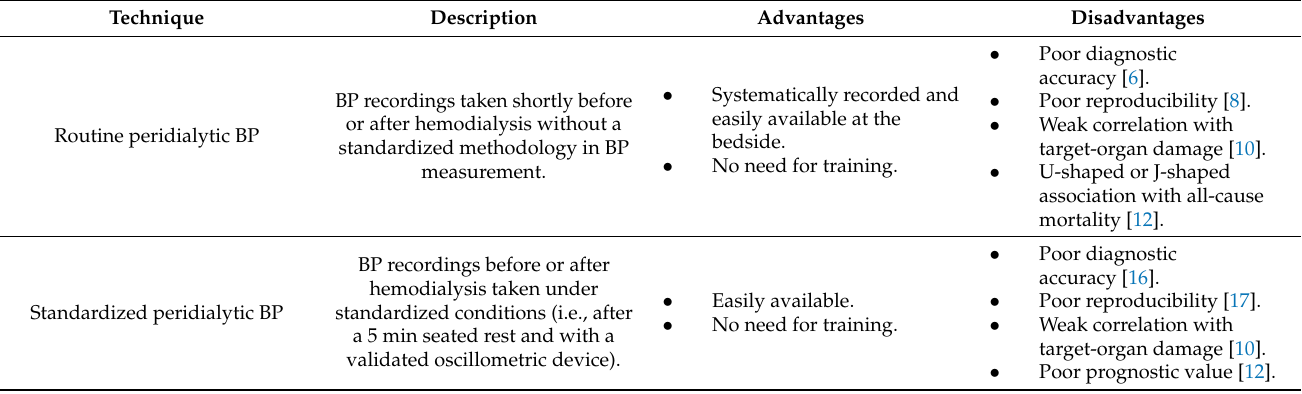
Table 1. Techniques for BP